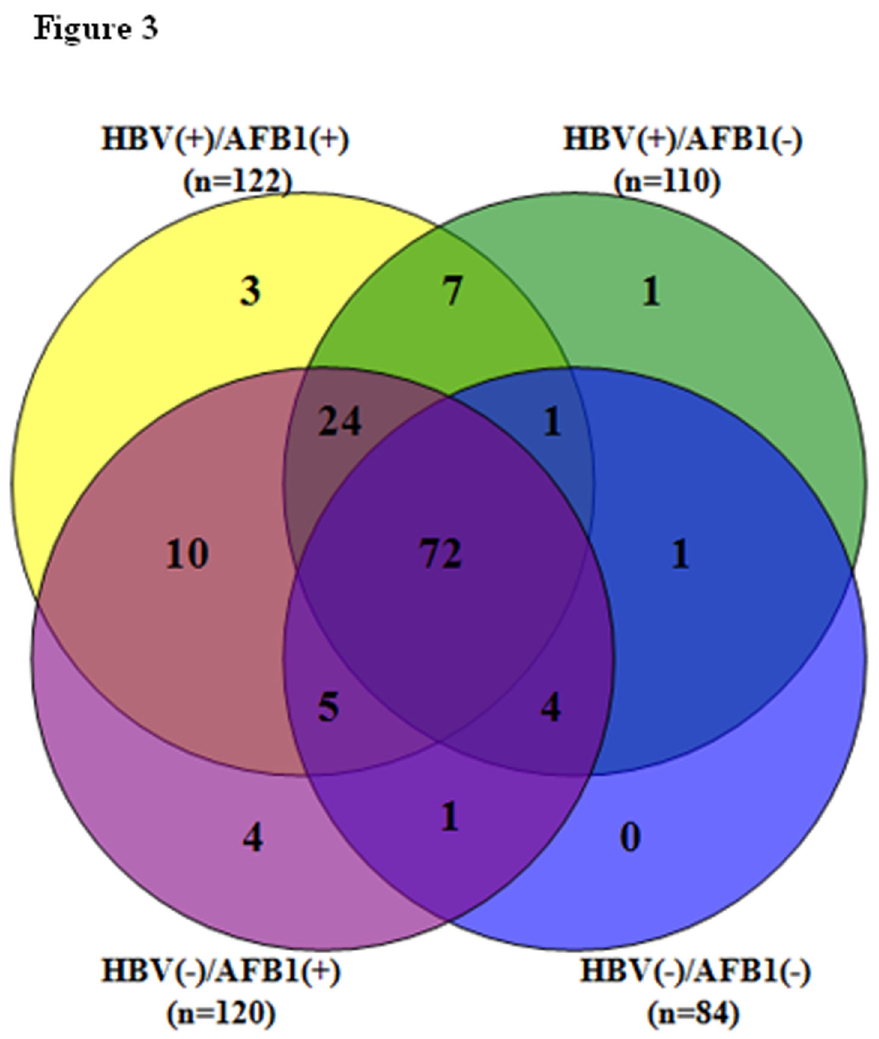
Figure 3. Venn diagram depicting the overlap of differentially expressed proteins quantified in the 4 groups based on HBV and AFB1 status. The number in parentheses indicates the number of differentially expressed quantified proteins in each group. doi: